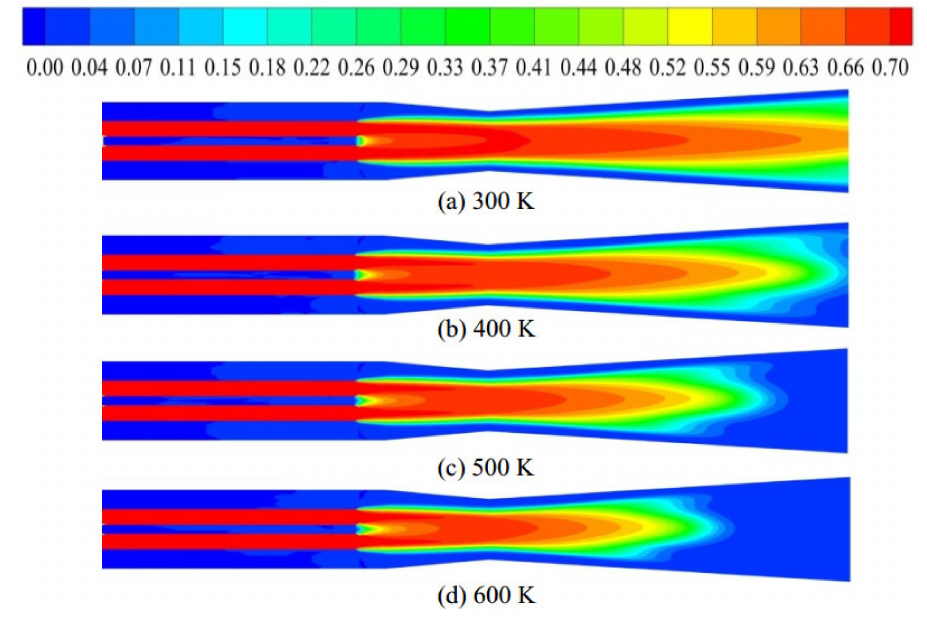
Figure 7. E ff ect of oxygen temperature on oxygen distributions along Z = 0